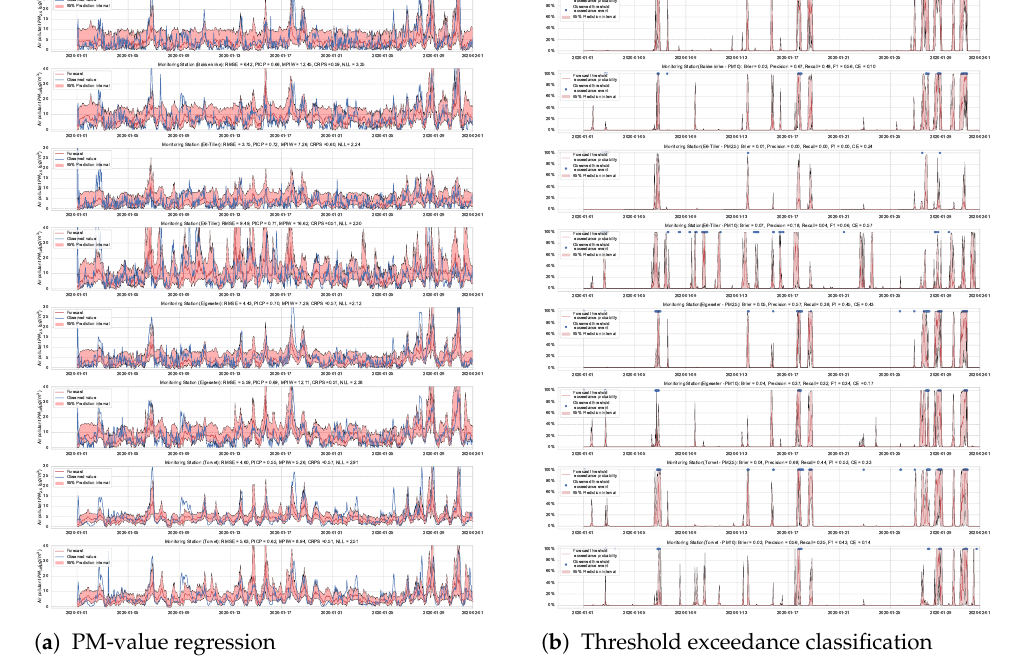
Figure A10. Deep probabilistic forecast of air quality using NNs with MC dropout at four monitor- ing